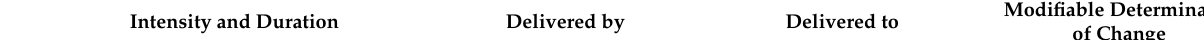
Table 1. Overview of the Healthy High School (HHS)